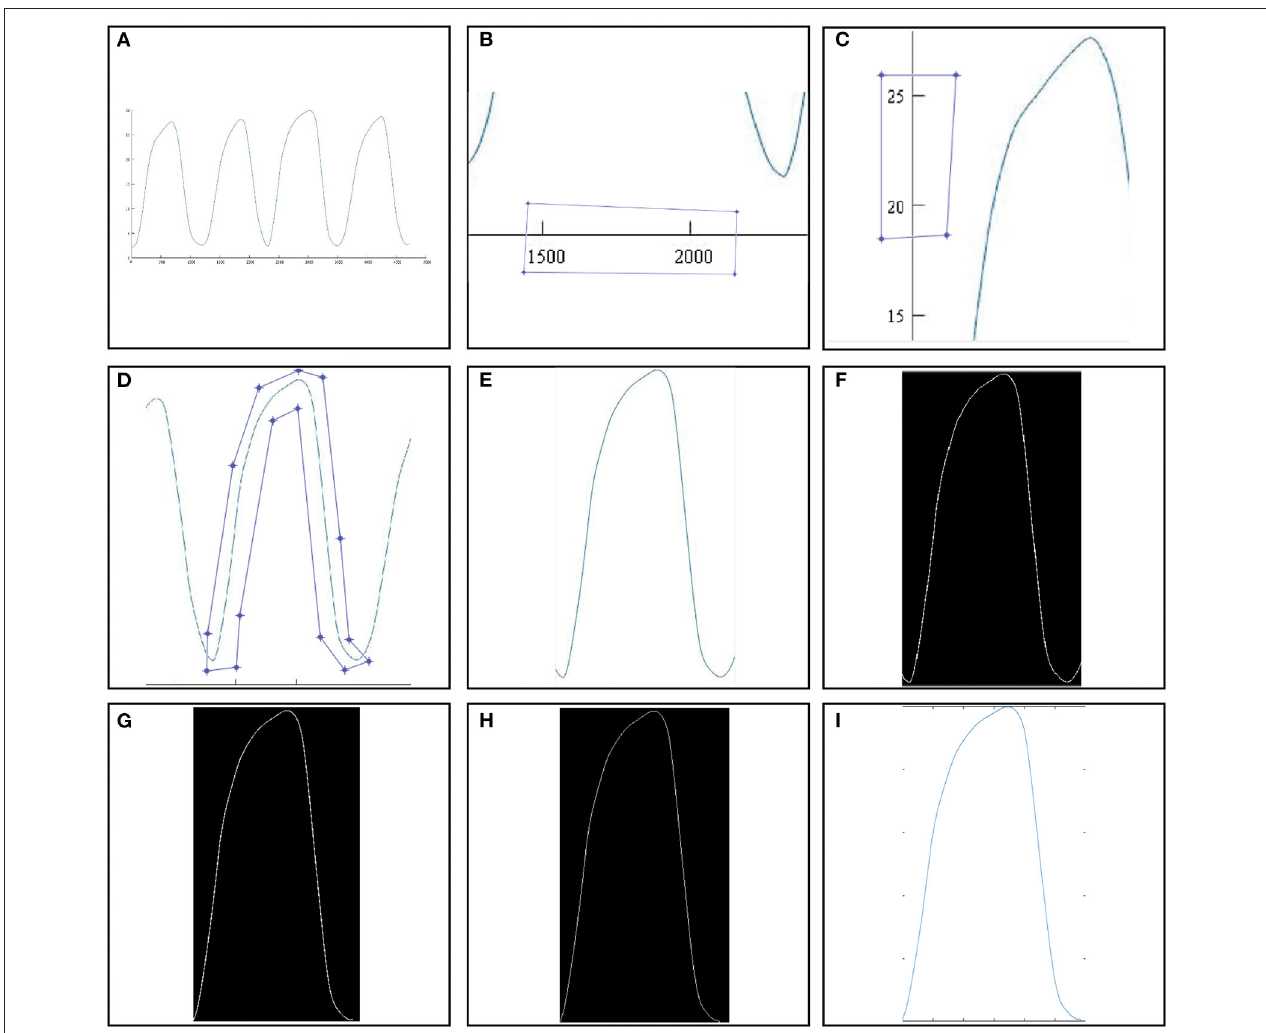
FIGURE 2 | Image processing algorithm of an image with capnograph. (A) Raw capnographic signal. (B) x-axis cropping. (C) y-axis cropping. (D) Breath waveform cropping. (E) Cropped breath waveform. (F) Binarized crop yield from image (E) . (G) Duration optimized single breath waveform. (H) Skeletonized version of image (G) . (I) “Digitized”